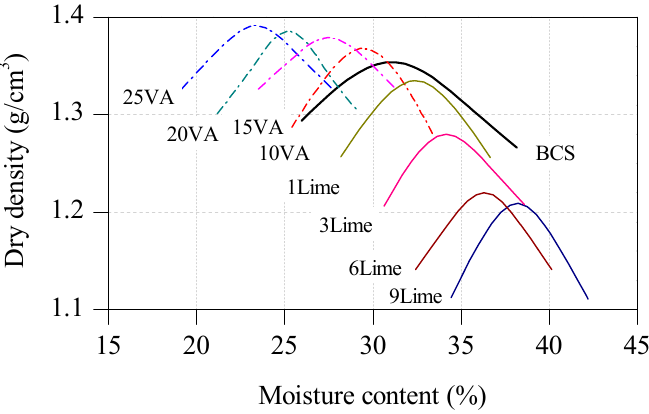
Figure 3. Influence of lime and VA content on the optimal moisture content (OMC) and maximum dry density (MDD) of BCS.